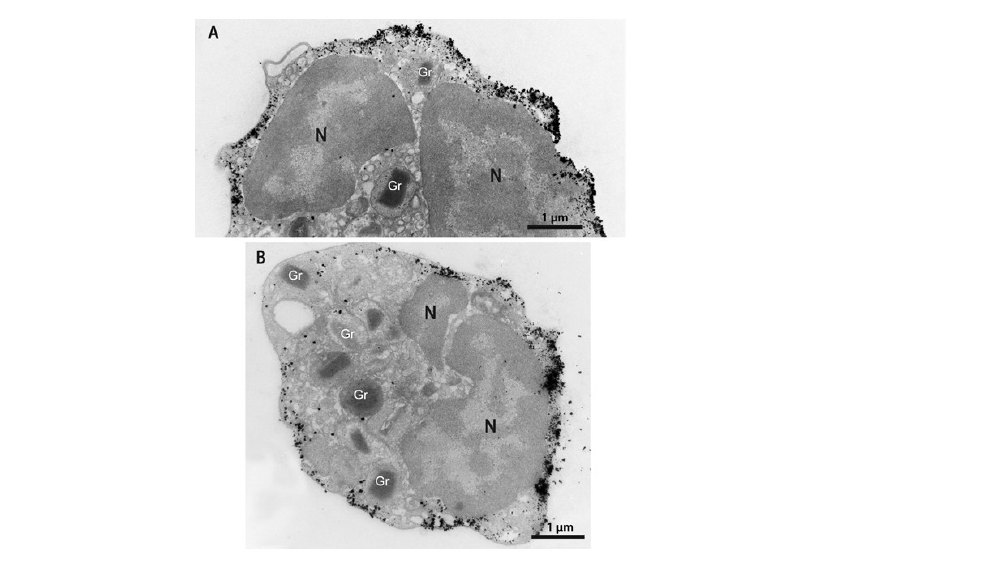
Figure 1. ( A , B ) Distribution of galectin-10 in the eosinophil cytoplasm. Note a robust pool of this protein as show by the deposition of gold particles in the peripheral cytoplasm and in association with the plasma membrane. Secretory granules (Gr) are negative. Isolated human eosinophils were processed for immunonanogold transmission electron microscopy for galectin-10, as previously described [50]. N, nucleus.